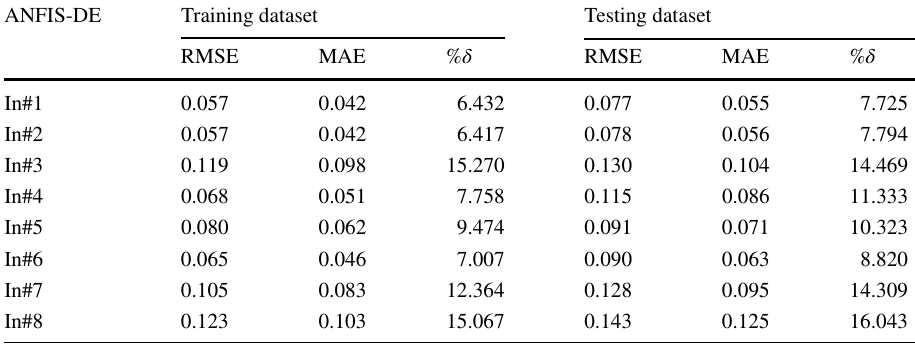
ANFIS-DE Training